Question: Generate an informative caption for the figure above.
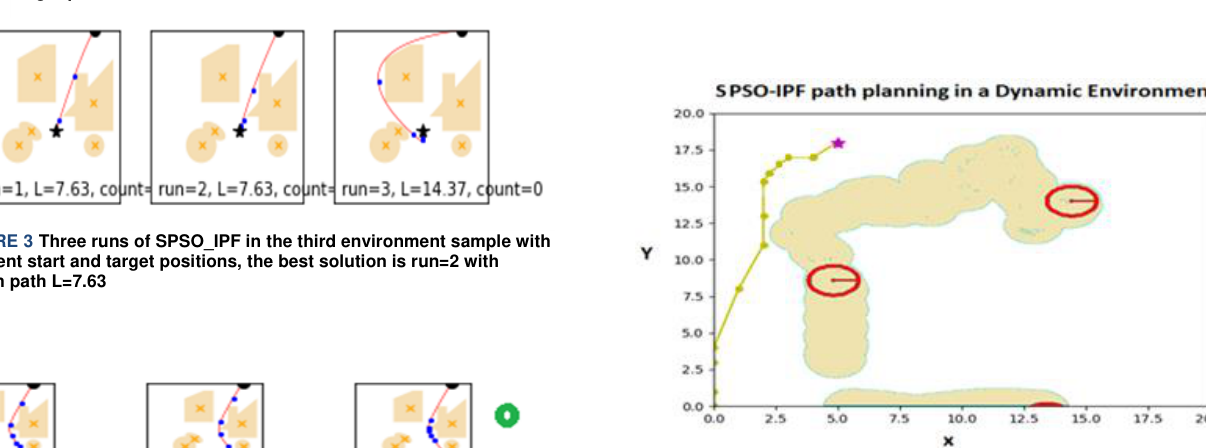
Answer: depicts the path generation performance by the  designed  SPSO-IPF  method.  Since,  for  real-time  applications, one run per epoch is considered, only the  collision avoidance criterion is seen in the generated path,  smoothness and shortest length path criteria do not  significantly play their roles in the generated way.